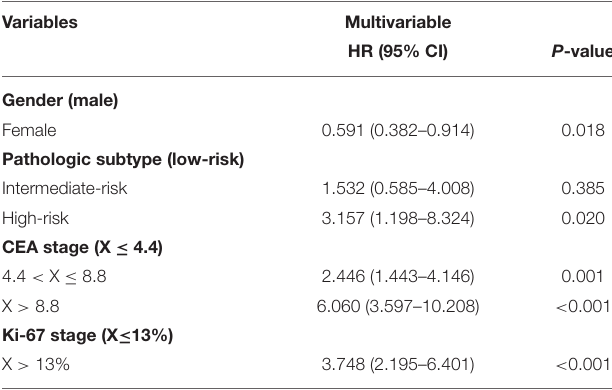
TABLE 2 | Cyclooxygenase (COX) multivariable analysis of 5-year disease-specific survival (DSS) in 650 patients with stage I pulmonary